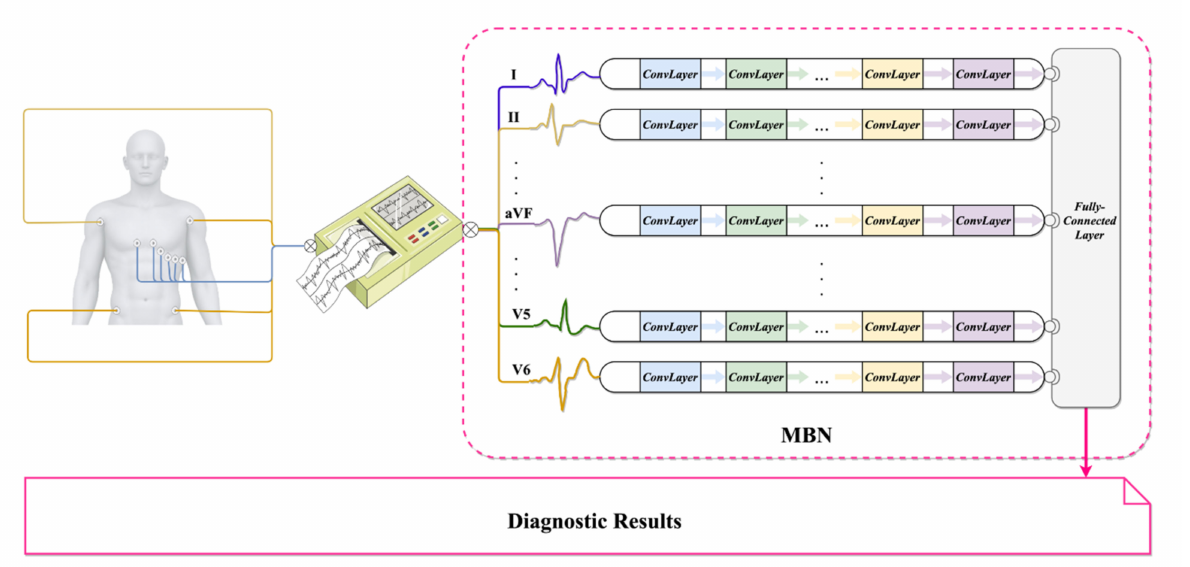
Figure 2. The conventional MBN skeleton. ConvLayer : A convolutional layer or a pooling